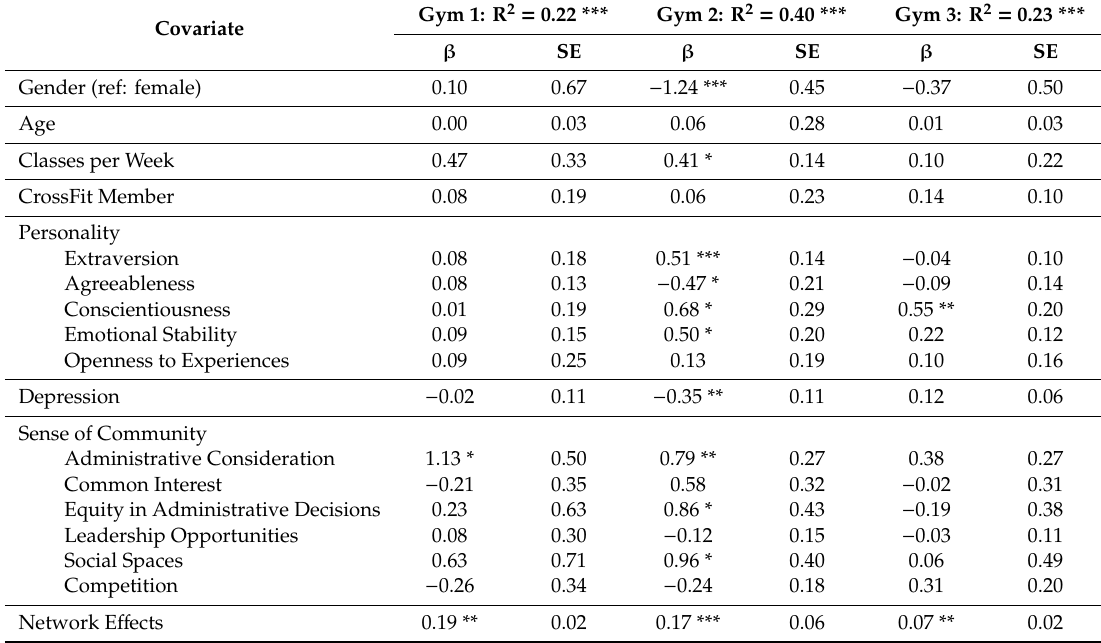
Table 3. Linear network autocorrelation models assessing tolerance scores in three CrossFit networks.